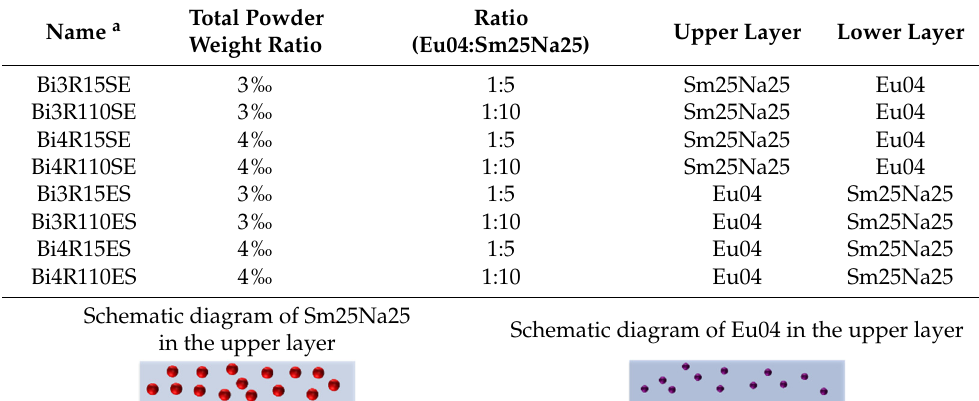
Table 5. The name of the double-layer polymeric luminescent coatings with different phosphor weight ratios.